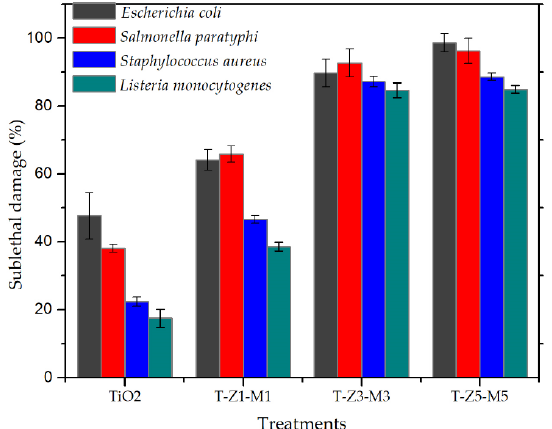
Figure 4. Sublethal damage of TiO 2 and mixed oxide nanoparticles (MONs) on pathogenic bacteria. T – Z1 – M1 is TiO 2 – ZnO (1%) – MgO (1%), T – Z3 – M3 is TiO 2 – ZnO (3%) – MgO (3%) and T – Z5 – M5 is TiO 2 –